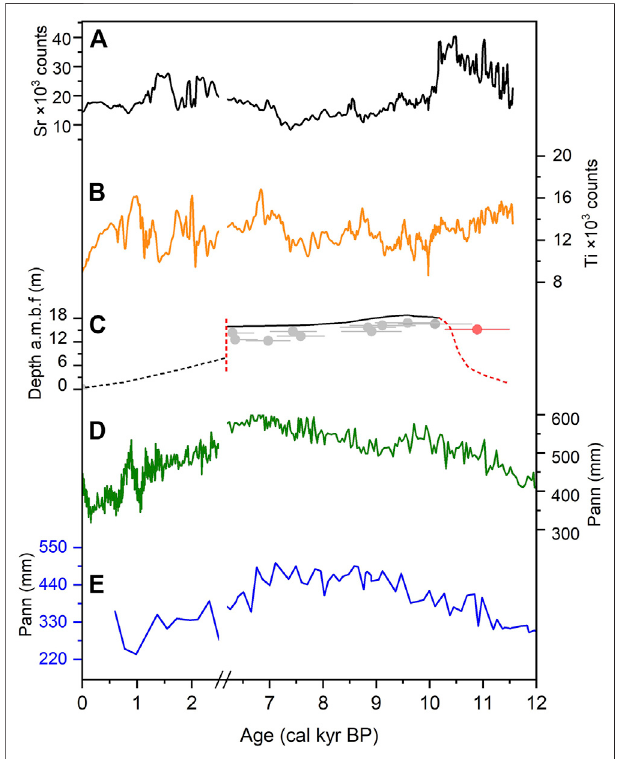
FIGURE 8 | Regional comparison by Sr content, (A) Ti content, and (B) lake level ( C , reorganize according Li et al., 2020) with precipitation from Gonghai ( D , Chen et al., 2015) and Bayan Chagan Nur ( E , Jiang et al., 2006).